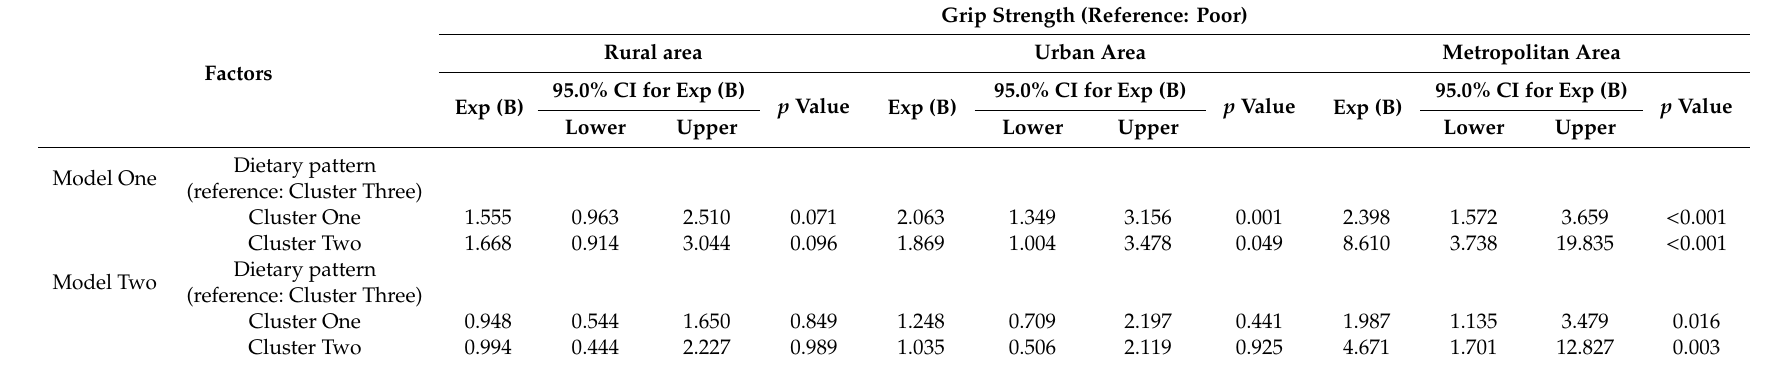
Table 4. Factors a ff ecting grip strength by residential